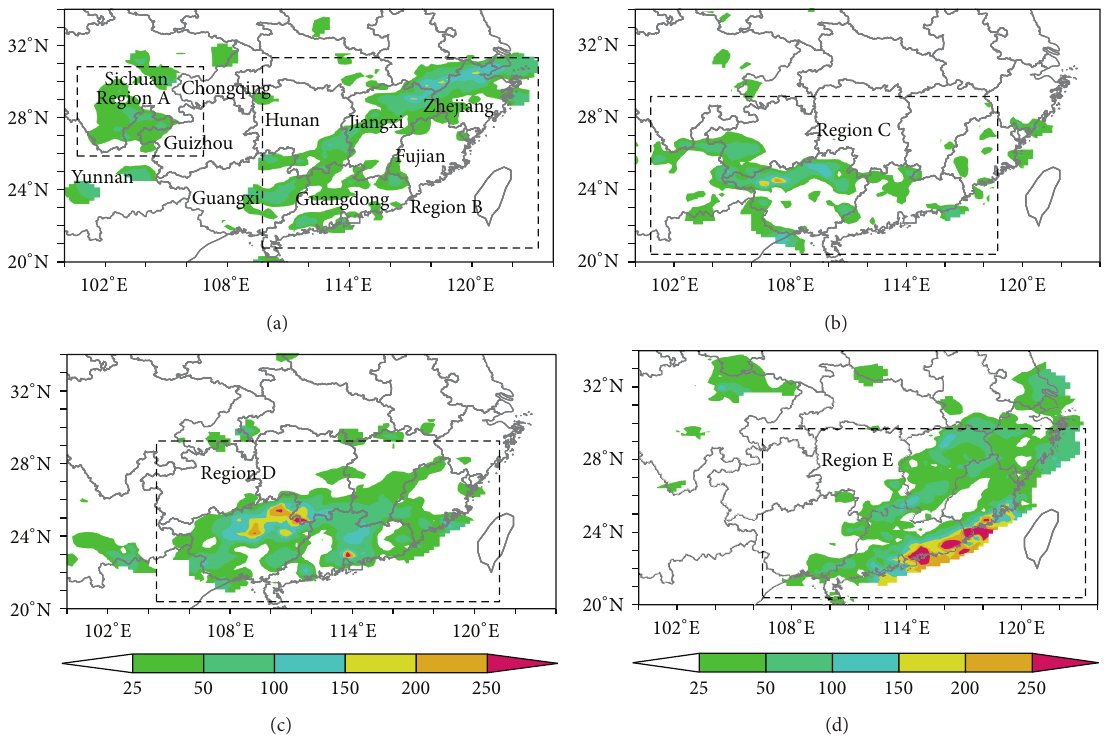
Figure 2: The daily precipitation distribution (mm) from 00 UTC to 24 UTC of (a) June 11, (b) June 12, (c) June 13, and (d) June 14 2008.